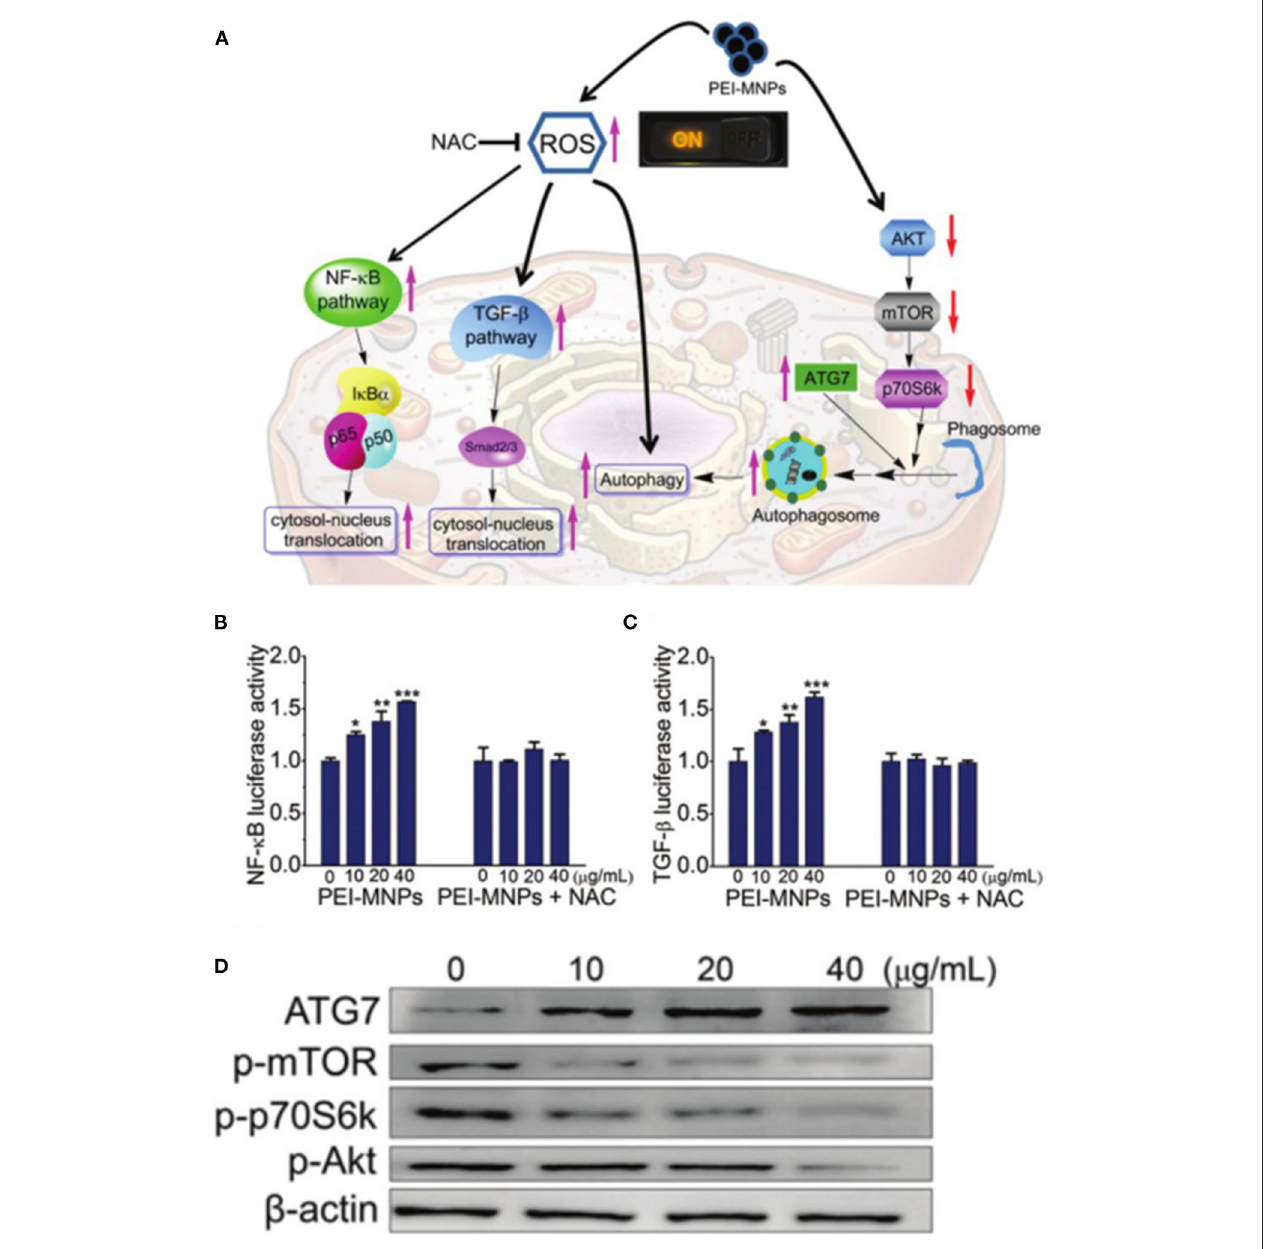
FIGURE 6 | (A) Schematic illustration for roles of ROS on PEI-MNPs elicited responses in cancer cells. (B,C) PEI-MNPs induced overproduction of ROS, triggering the activation of NF- κ B and TGF- β pathways. (D) Western blotting experiments of the cancer cells treated with PEI-MNPs. * P < 0.05 ; ** P < 0.01 ; *** P < 0.005 vs controls. Reproduced, with permission, from Man et al. (2020). Copyright 2020, Royal Society of